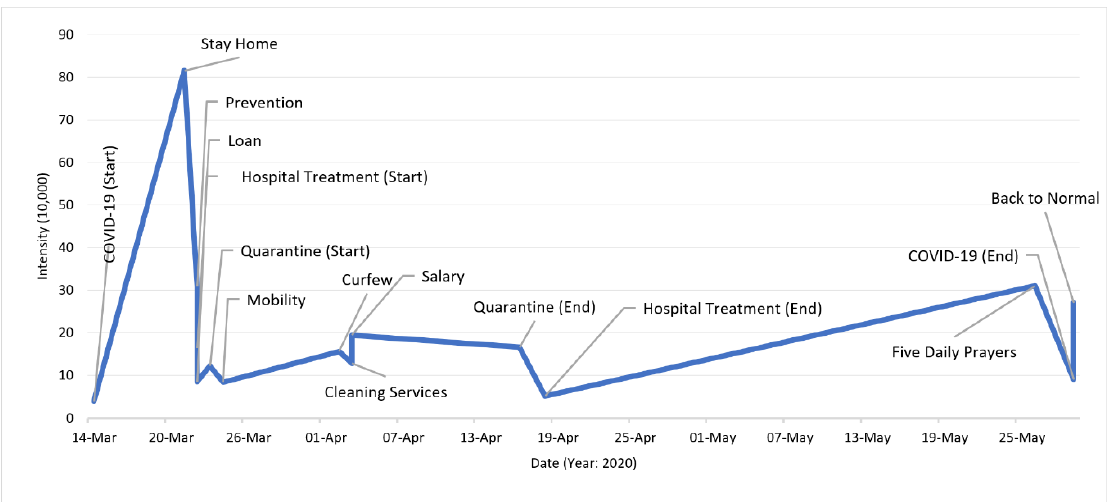
Figure 1. The timeline of some of the detected government pandemic measures and public concerns.